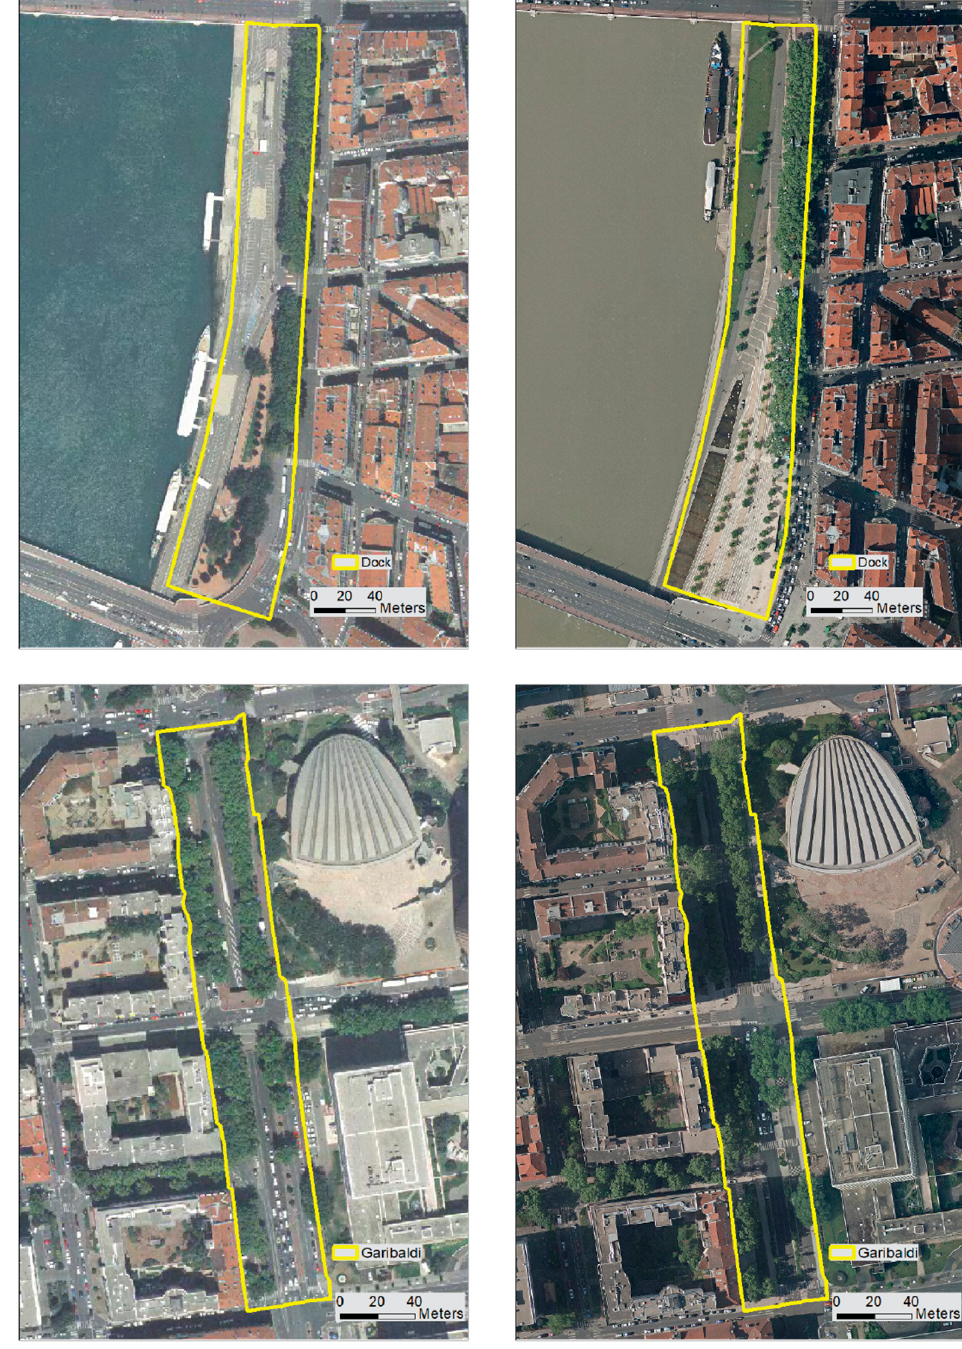
Figure 3. Dock ( top ) and Garibaldi ( bottom ) sites in 2003 ( left ) and 2015 ( right Figure 3. Dock (top) and Garibaldi (bottom) sites in 2003 (left) and 2015 (right). The last site is the Groupama Stadium. It is the new stadium of the OL football team (www.ol.fr). This team’s matches were previously held in a dilapidated stadium in the city center. Groupama Stadium (€410 million) was built on agricultural and wooded land in the eastern part of